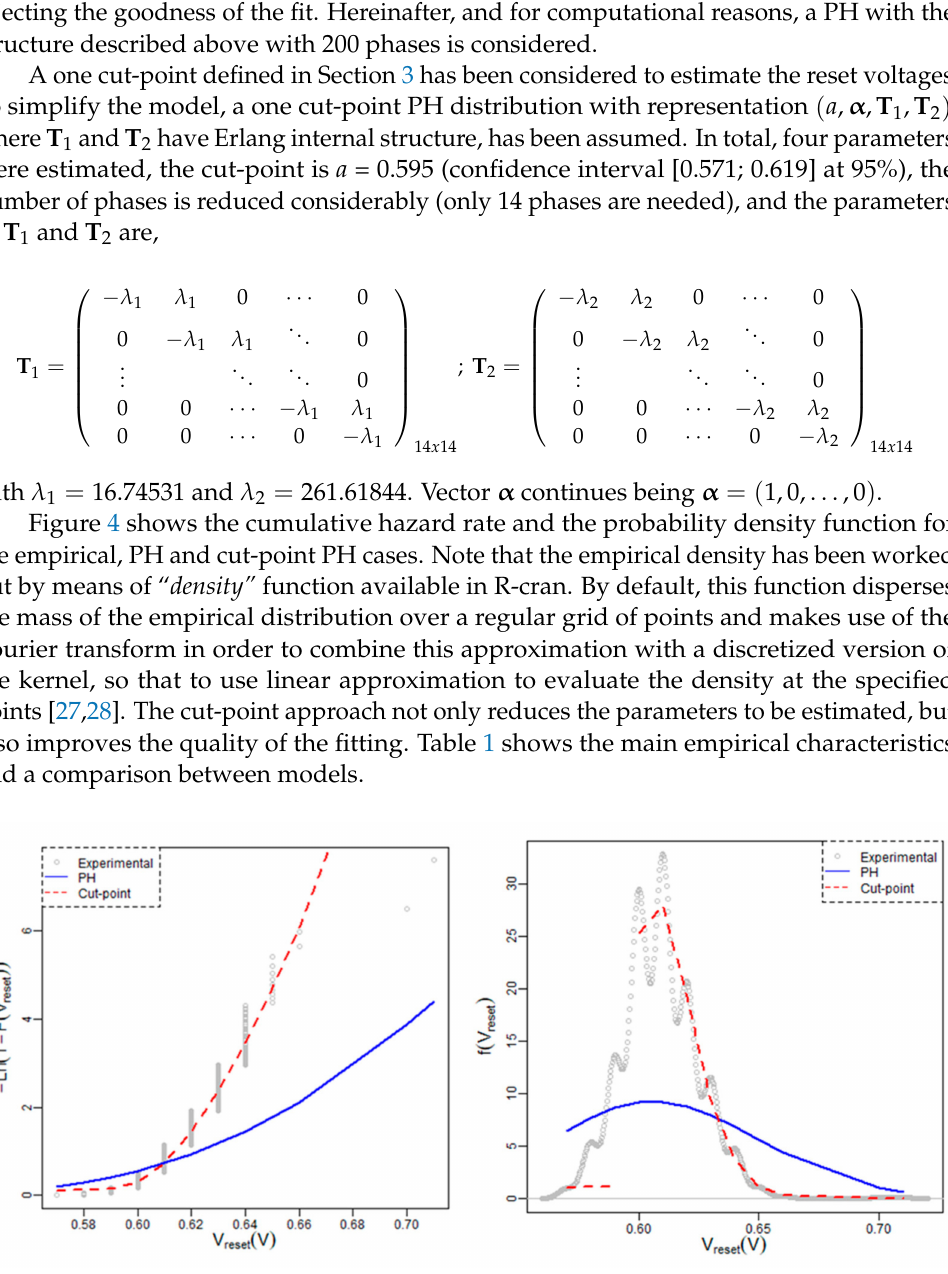
Figure 4. Cumulative hazard rate ( left ) and probability density function ( right ) for 1000 reset voltages (the absolute value was employed for the plot) and the corresponding PH and cut-point PH